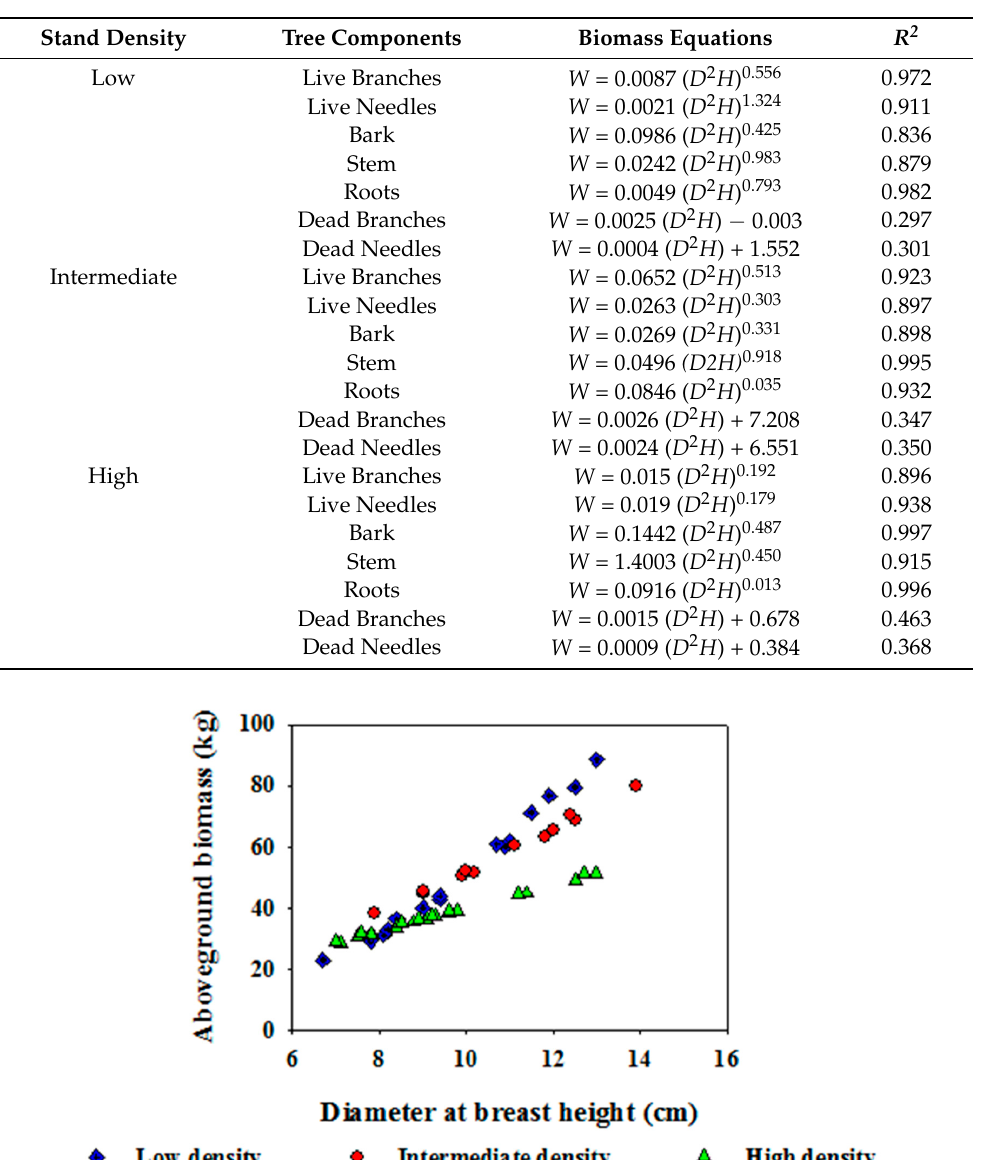
Table 1. Allometric equations for estimating biomass of different tree components of Chinese fir planted at different initial stand density levels (D = DBH, H = height).